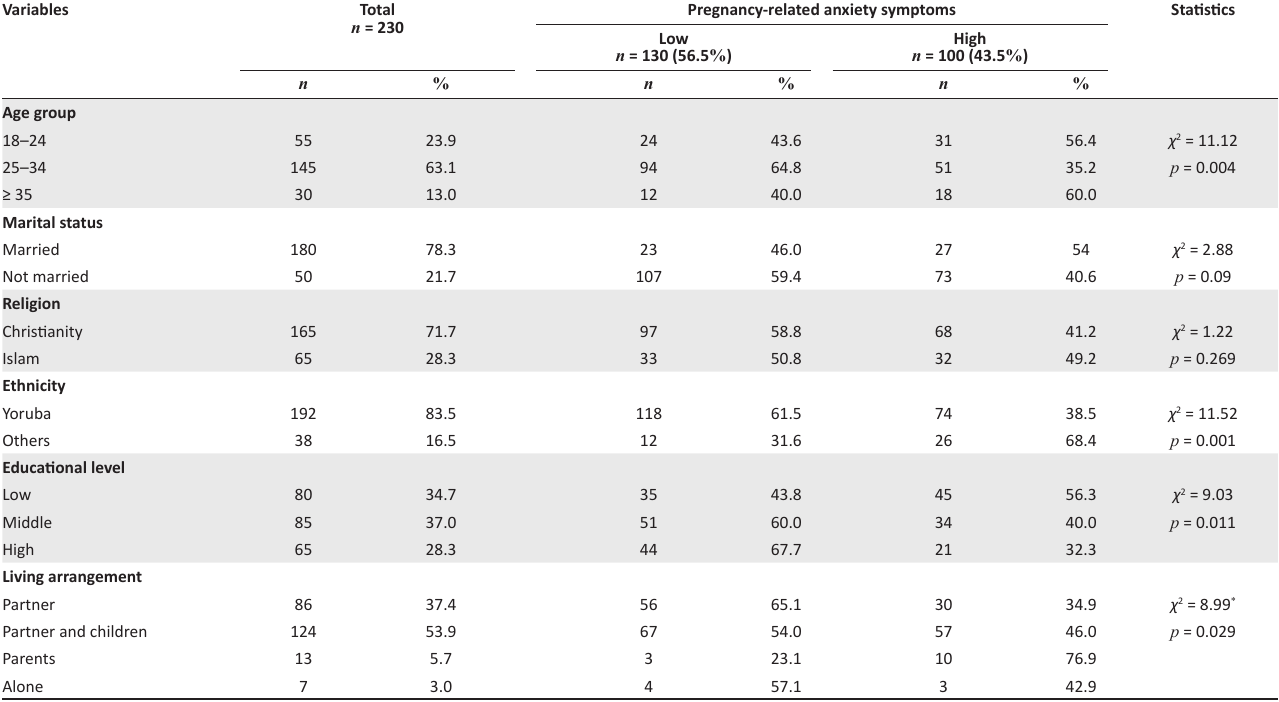
TABLE 2: Socio-demographic factors in association with pregnancy-related anxiety symptoms amongst respondents.